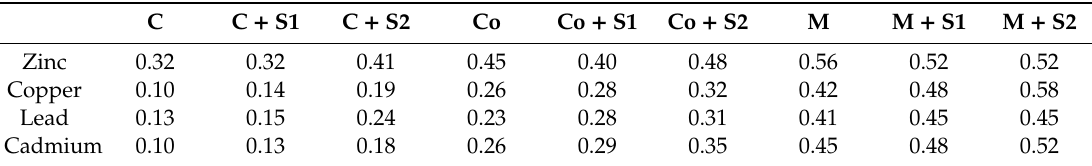
Table 2. Bioaccumulation Factor (BAF) calculated for metal contents (Zn, Cu, Pb and Cd) in alfalfa grown in clay soil (C) amended with or without MSW compost (Co) and Farmyard manure (M)